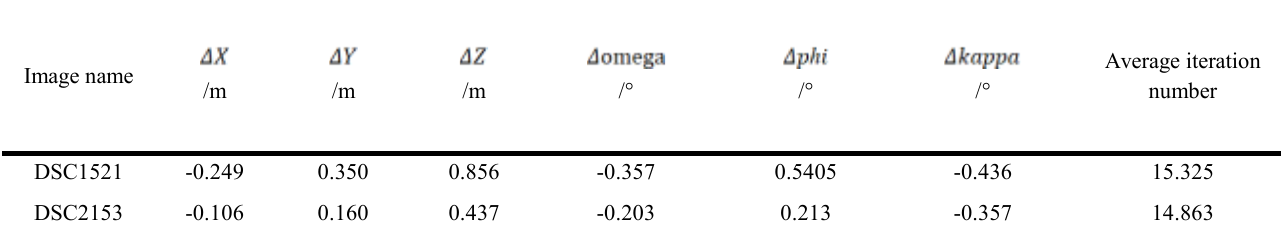
Table3. The effect of the initial values of elements of exterior orientation on the matching